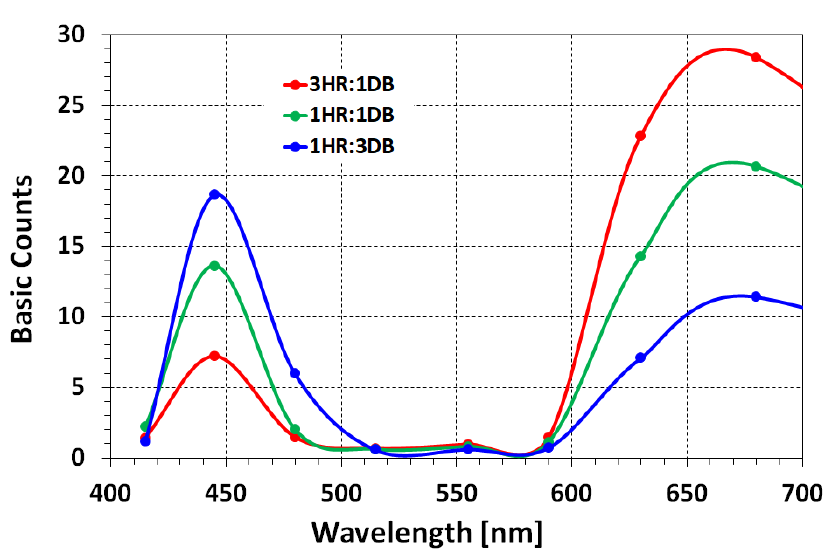
Figure 1. Comparison of the qualitative light spectrums for the considered modules: 3HR:1DB, 1HR:1DB, and 1HR:3DB, obtained using the low-cost AS7341 spectral sensor. Each curve is obtained by the interpolation of the dimensionless output values of the eight optical channels of the sensor with filters centered at wavelengths of 415, 445, 480, 515, 555, 590, 630, and 680 nm, respectively (marker dots). DB: deep blue, HR: hyper red.